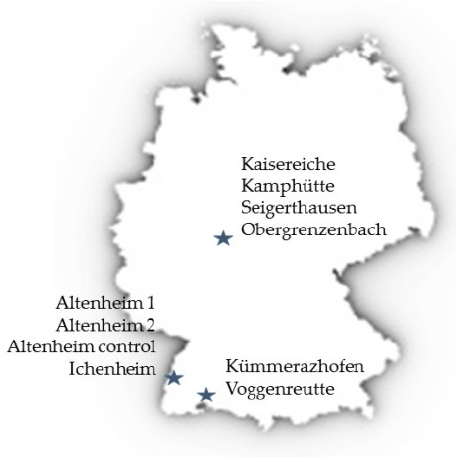
Figure 1. Location of study sites in Germany (map not to scale).